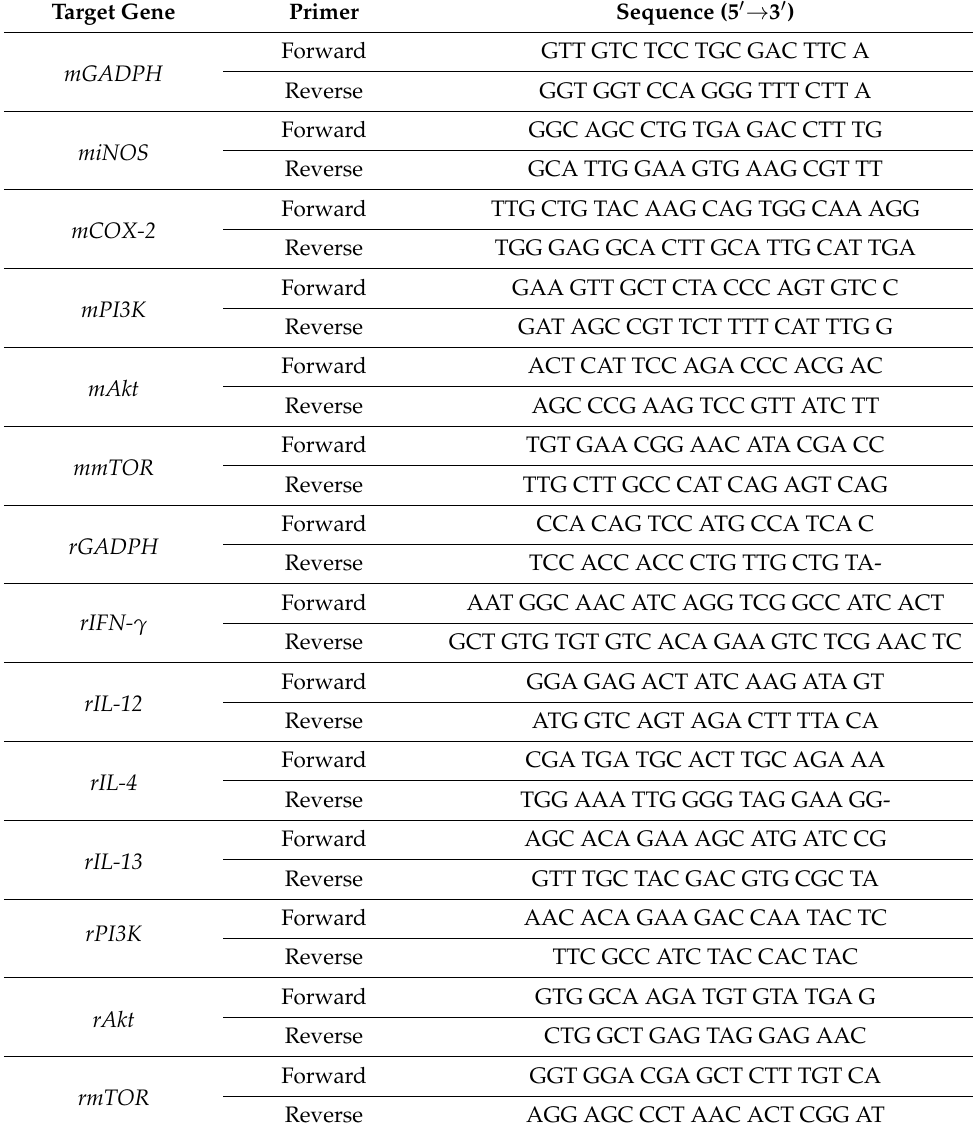
Table 1. The primer sequence used for